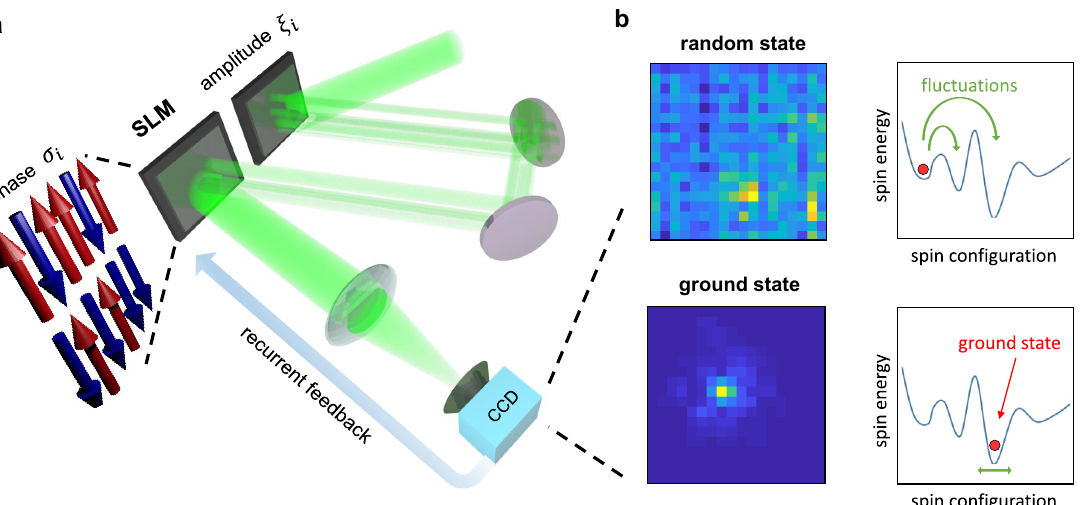
Figure 1: Photonic Ising machine by spatial light modulation. (a) The spins σ i (cid:1) ± 1 are encoded by a spatial light modulator (SLM) into binary optical phases ϕ (cid:1) 0 , π in separated spatial points of the optical wavefront. Intensity modulation is employed to set the spin interaction via the amplitude distribution ξ . Recurrent feedback from the far- fi eld camera allows evolution of the phase con fi guration towards the Ising i ground state. (b) Intensity detected on the camera (CCD) modes for a random spin state and for the ground state of a ferromagnetic Ising model. Insets are illustrations of the corresponding spin state in energy landscape. Experimental fl uctuations allow spontaneous changes in the spin con fi